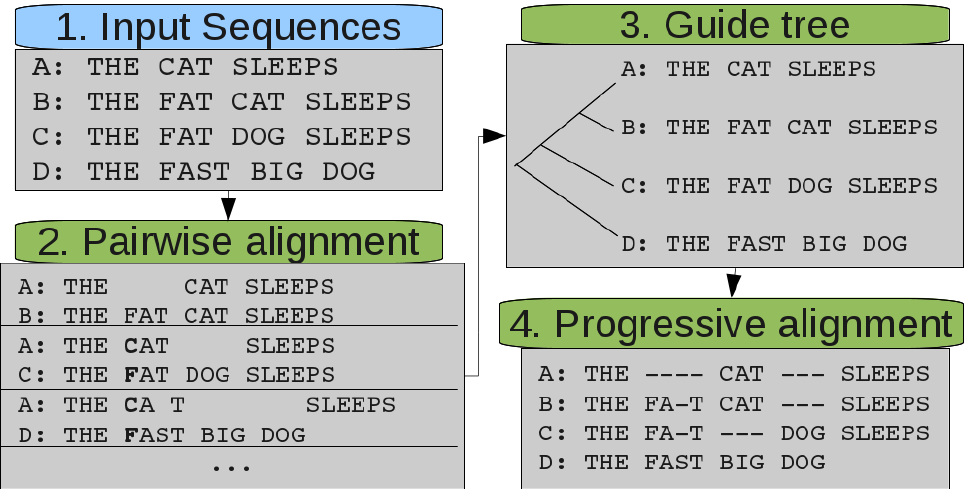
Figure 2: MSA: Multiple Sequence Alignment